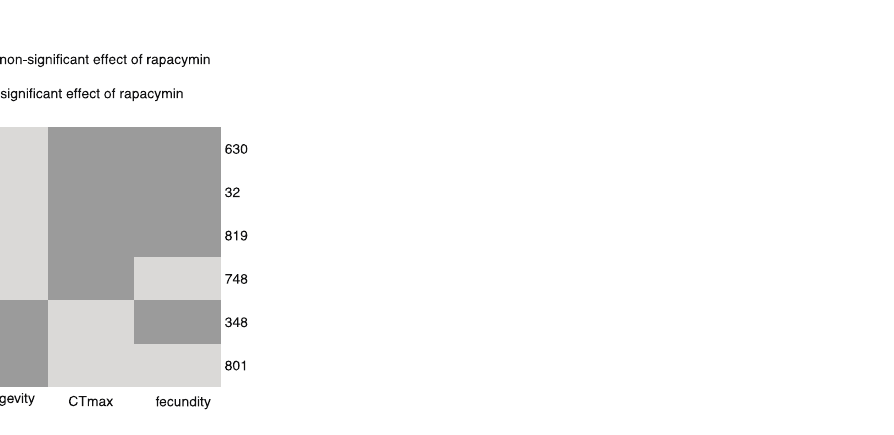
Figure 5. Result overview of significant within DGRP-line treatment effects (DGRP line ID is shown to the right on the figure). to the right on the